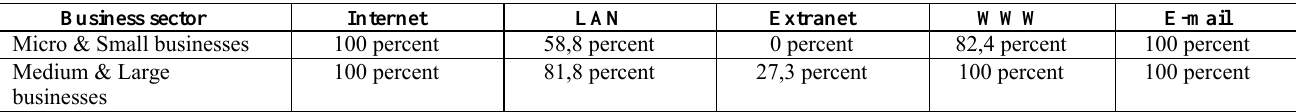
Table 6: Technology use amongst micro-small and medium-large businesses Business